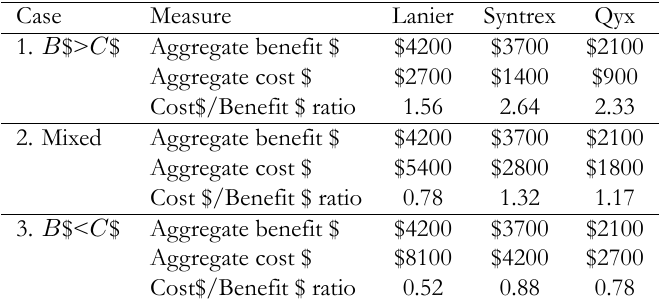
Table 2. Cost-Benefit ratios with different sets of dollar amounts